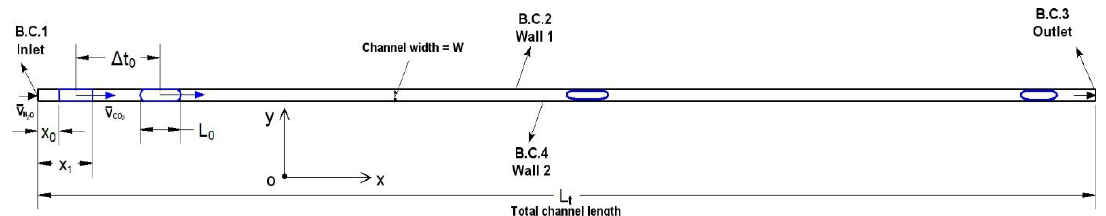
Figure 1. Schematic of the 2D computational domain for a single flowing liquid CO 2 or scCO 2 drop (outlined by either a rectangle at the left-hand side or a capsular shape in the middle and at the right-hand side) with water (regions outside of the drop) in a long straight microchannel (total length L t = 15 mm and channel width W = 0.15 mm). The CO 2 drop and water both flow from left to right. The origin of the coordinate is located at the center of the inlet, x -axis is in the channel length direction and y -axis is in the channel width direction. The drop here shows its presence at different moments.